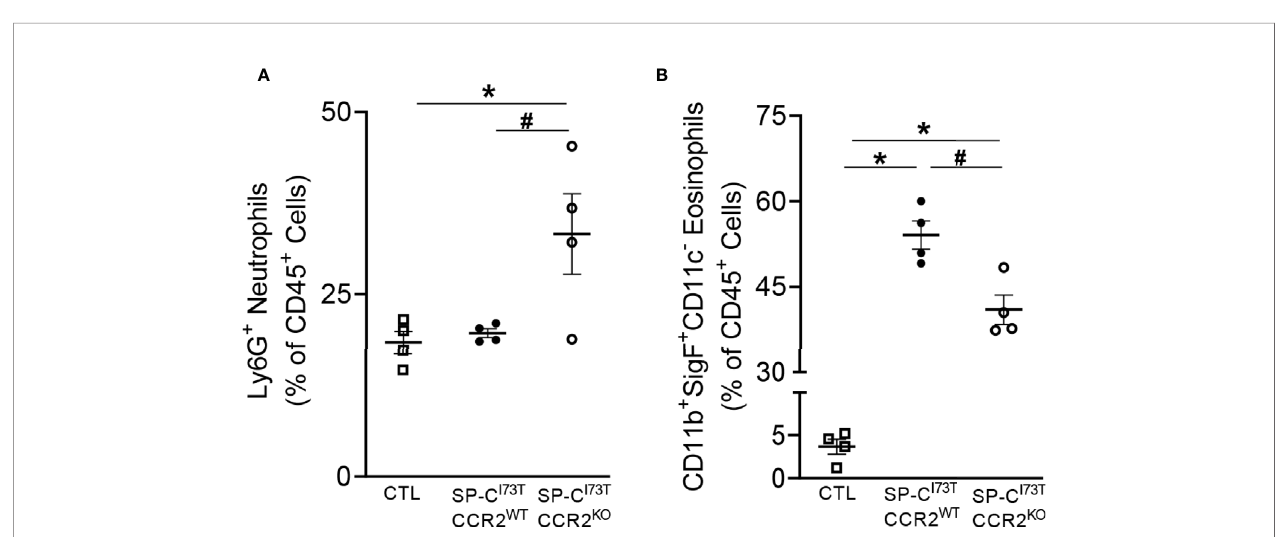
FIGURE 6 | CCR2 monocyte depletion results in altered polymorphonucleated cell in fl ux following SP-C I73T induced injury. Changes in relative abundance of tissue (A) Ly6G + neutrophils and (B) SigF + CD11c - CD11b + eosinophils isolated by enzymatic digested (collagenase D) from control (CTL, tamoxifen treated SP-C WT or oil treated SP-C I73T mice), SP-C I73T CCR2 WT and SP-C I73T CCR2 KO 14 d following injury. Data are represented as mean ± SEM (N = 4). All analysis was considered signi fi cant *p<0.05 compared to control mice; # p<0.05 compared to SP-C I73T CCR2 WT mice by One-Way ANOVA, using Tukey post- hoc